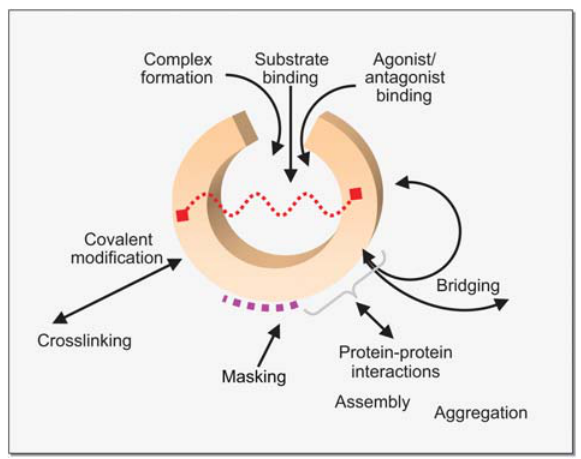
Figure 2 The various modes of polyamine interactions with